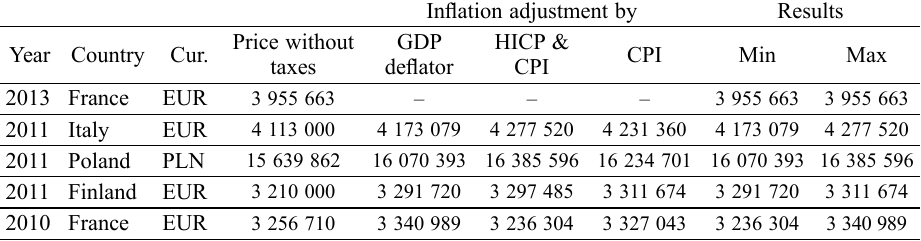
Table 3. Inflation-adjusted prices for tomotherapy units from public-procurement databases Inflation adjustment by Results